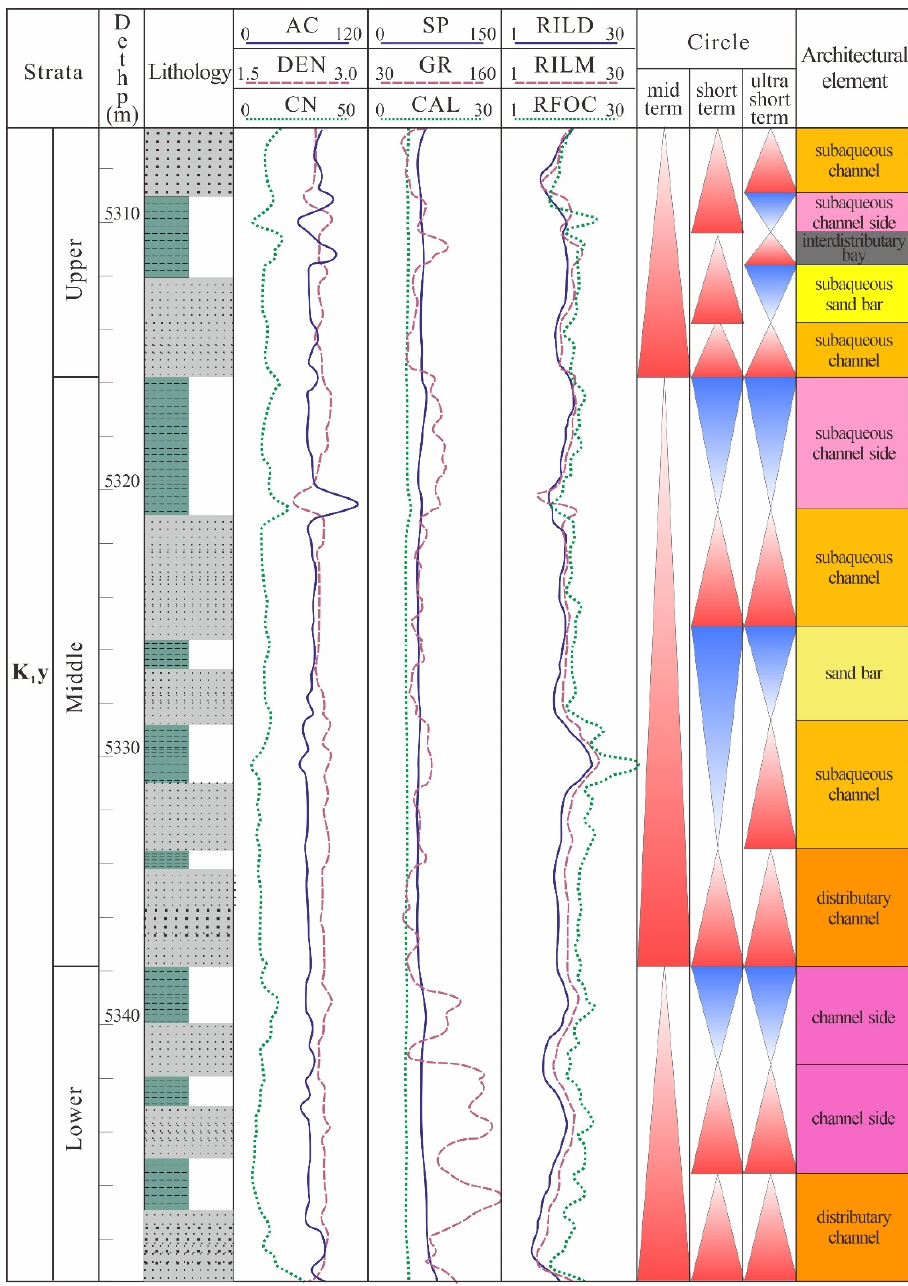
Figure 7. Bounding surfaces’ discrimination and sandstone architectural element determination of a typical well in Yakela area.